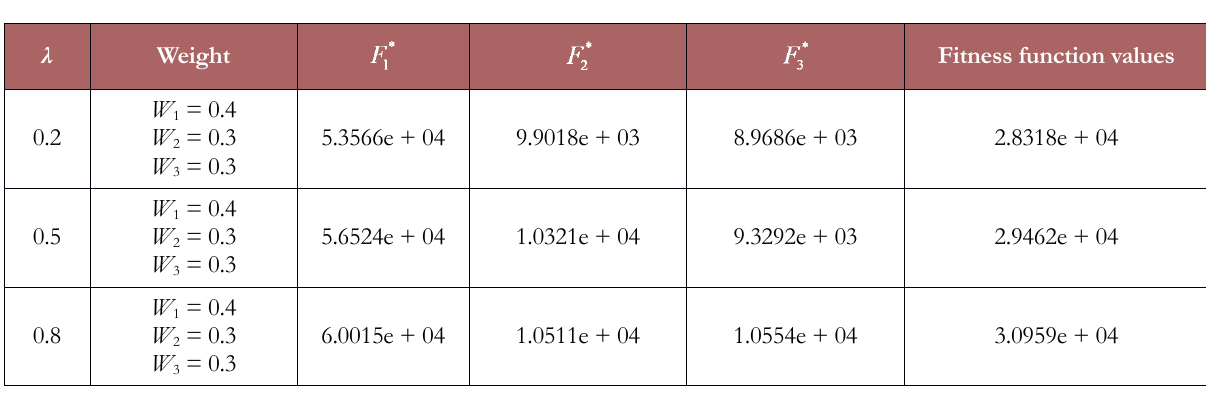
Table 5. Sensitivity with respect to parameter λ